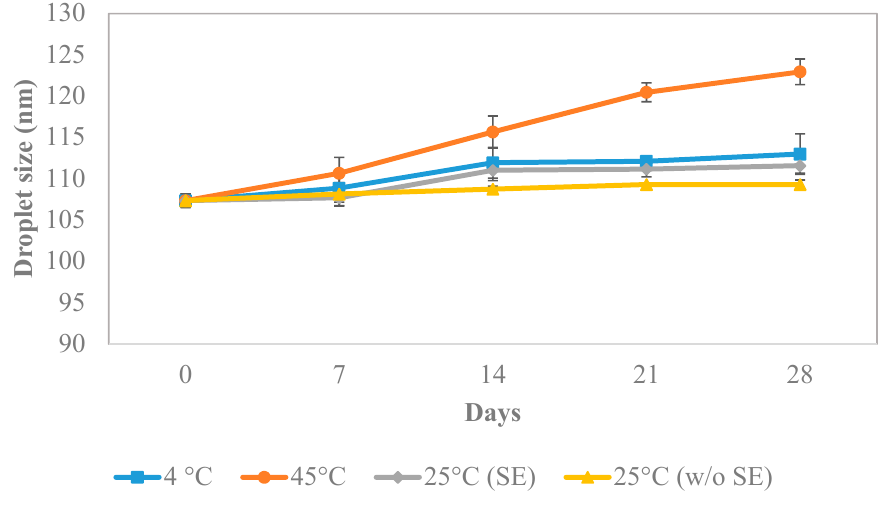
Figure 5. Graph of droplet size (nm) observed for 28 days under four di ff erent conditions (SE; sunlight exposure).